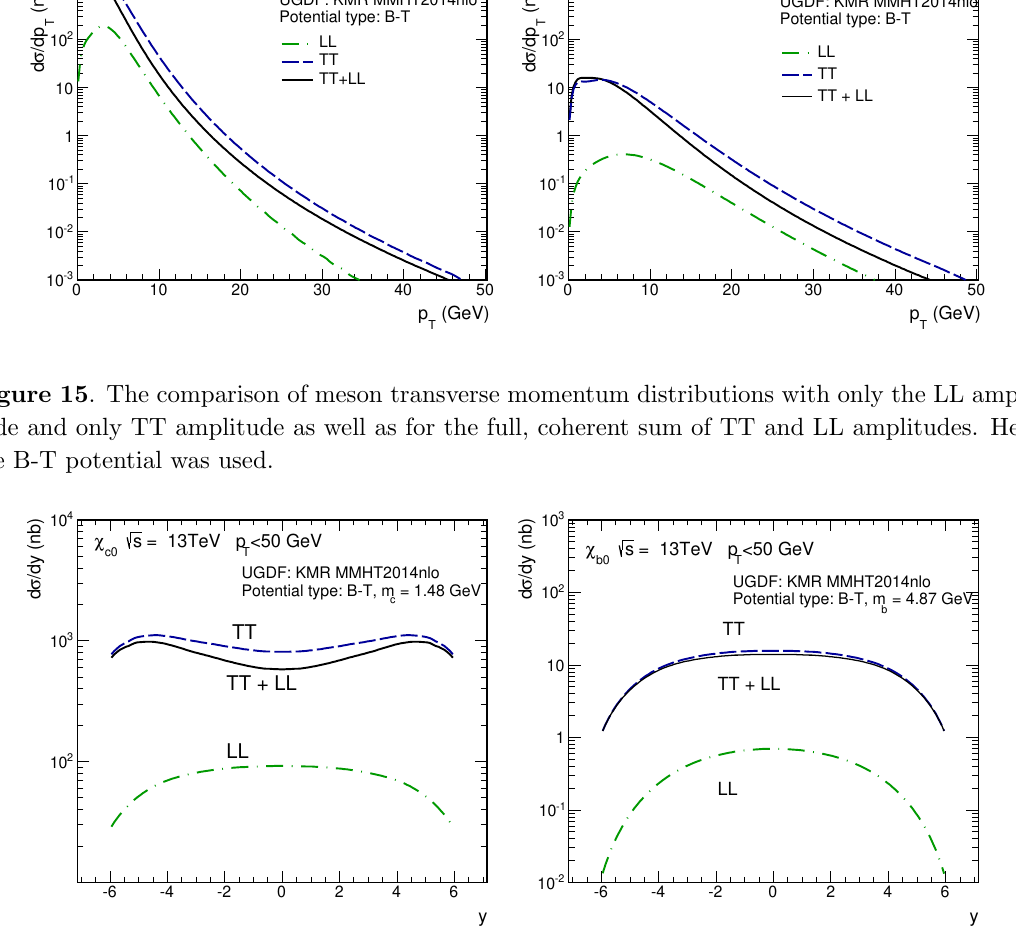
Figure 16 . The comparison of meson rapidity distribution with only LL amplitude and only TT amplitude as well as for the full coherent sum of TT and LL amplitudes. Here the B-T potential was